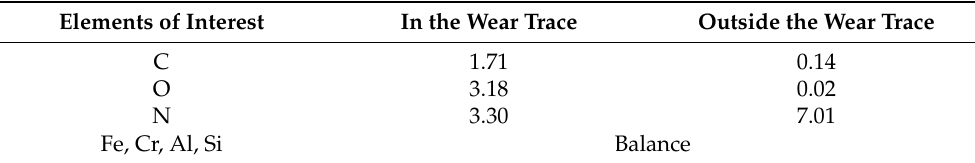
Table 5. Atomic [%] composition of the wear traces on the plate observed after the tribo-test of W + IL-DEE. Elements of